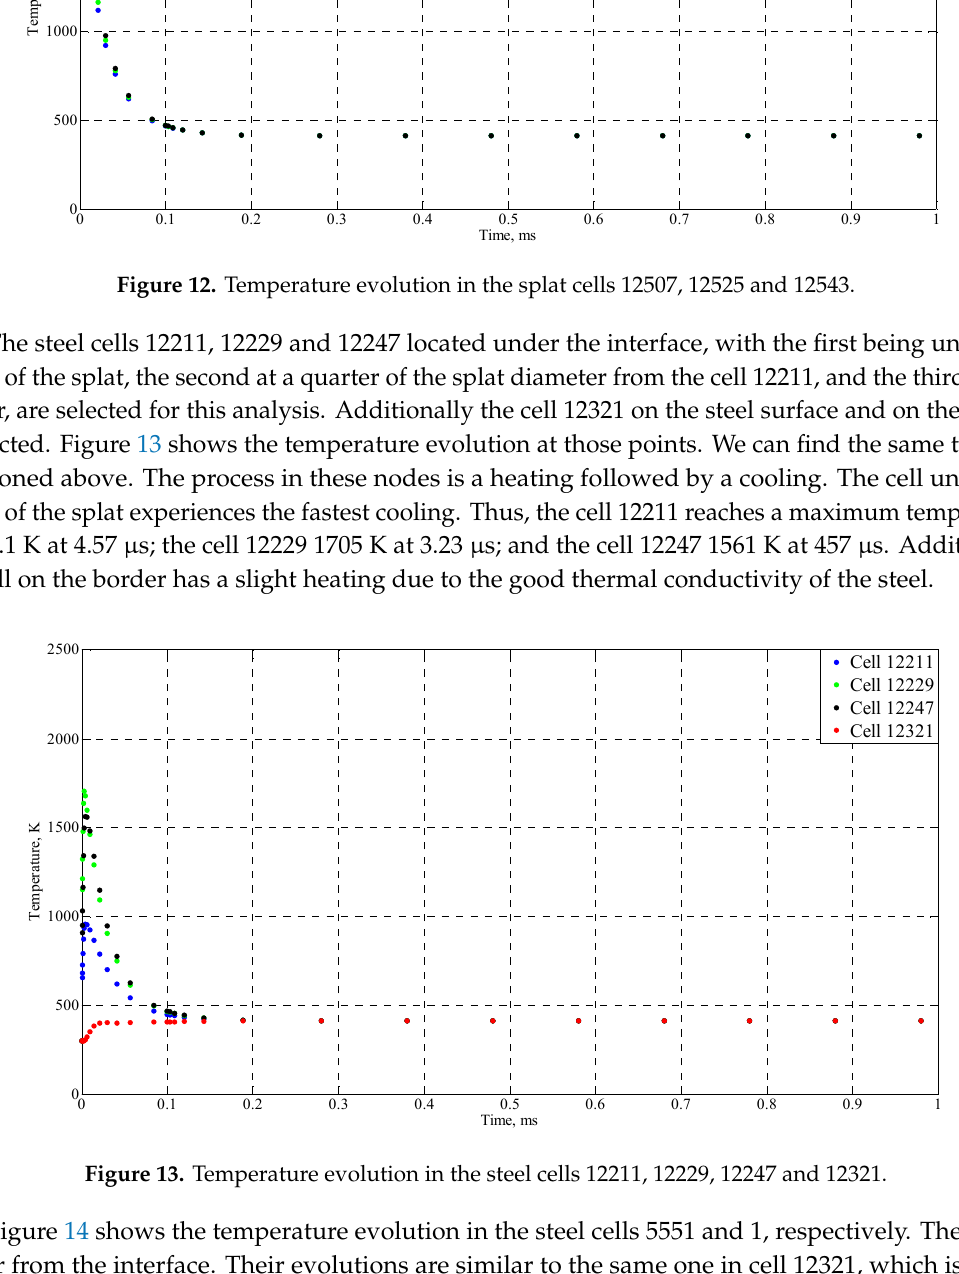
Figure 11. Temperature evolution in the splat cells 12655, 12673 and 12691.